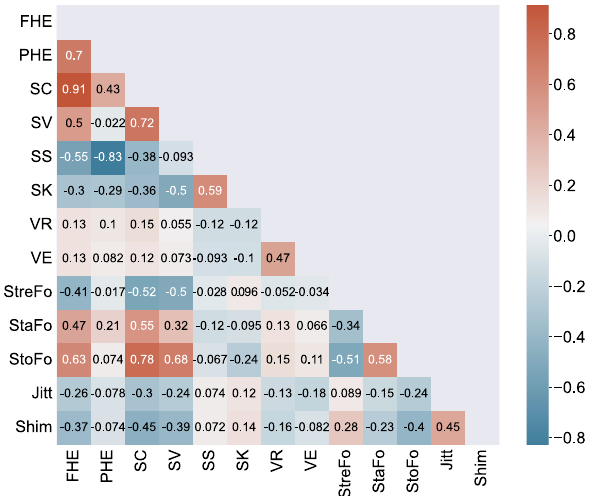
Figure 2. Correlation heat map showing the relationships between candidates for the input features in a random forest model. FHE frequency of half energy, Jitt Jitter, PHE position of half energy, Shim Shimmer, StaFo Start of formant, StoFo Stop of formant, StreFo Strength of formant, SC spectral centroid, SK spectral kurtosis, SS spectral skewness, SV spectral variance, VE vibrato extent, VR vibrato rate.